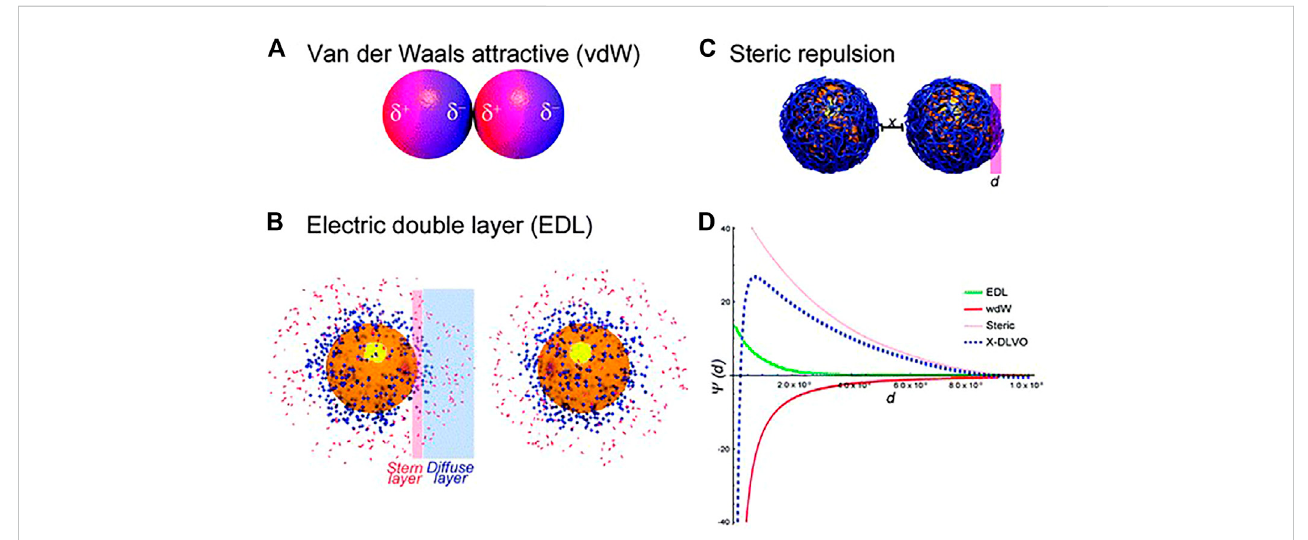
FIGURE 5 Schematics of colloidal interactions (A – C) and illustration of potential energy-distance curves describing colloidal interactions (D) (Moore et al., 2015).